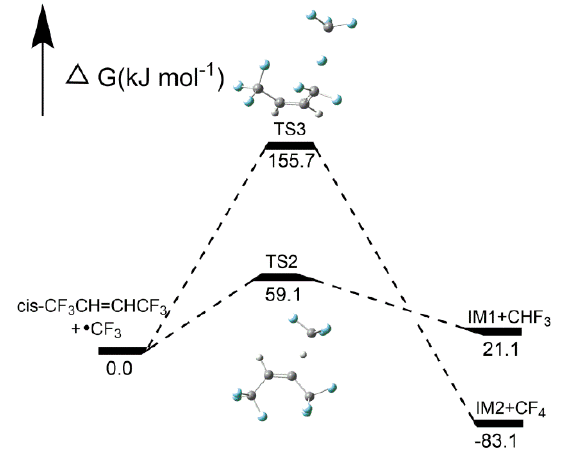
Figure 11. Energy profiles for intramolecular elimination reaction. C, H and F atoms are represented with black, gray and blue balls, respectively.